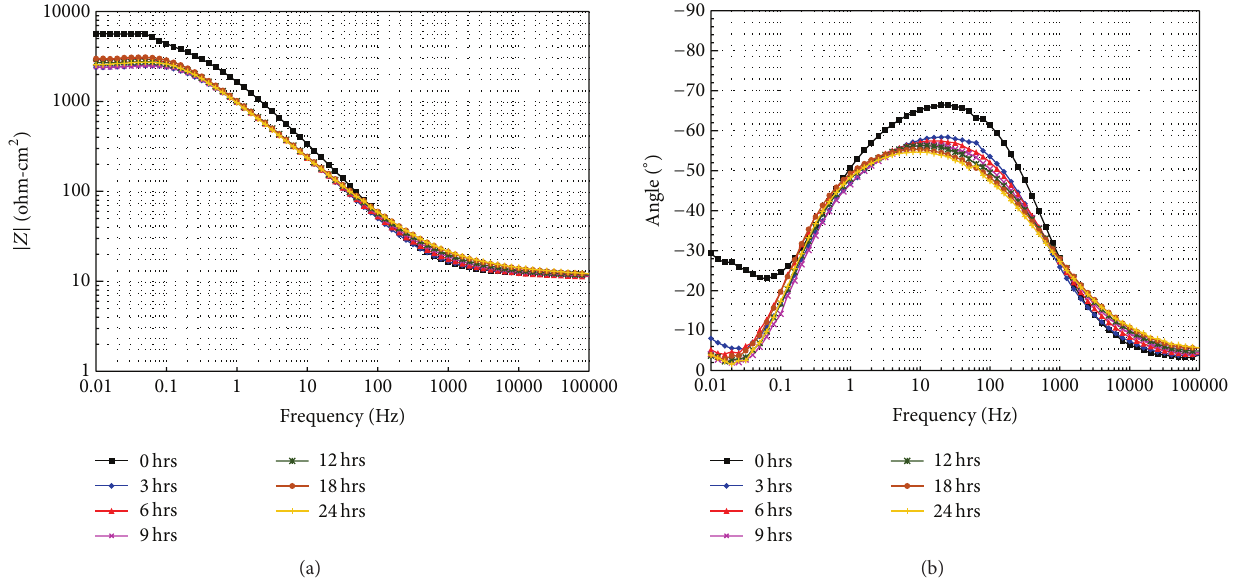
Figure 9: Bode plots for 40Nd3Co magnet tested in 3.5% NaCl solution at 25 ∘ C for 24 hours.